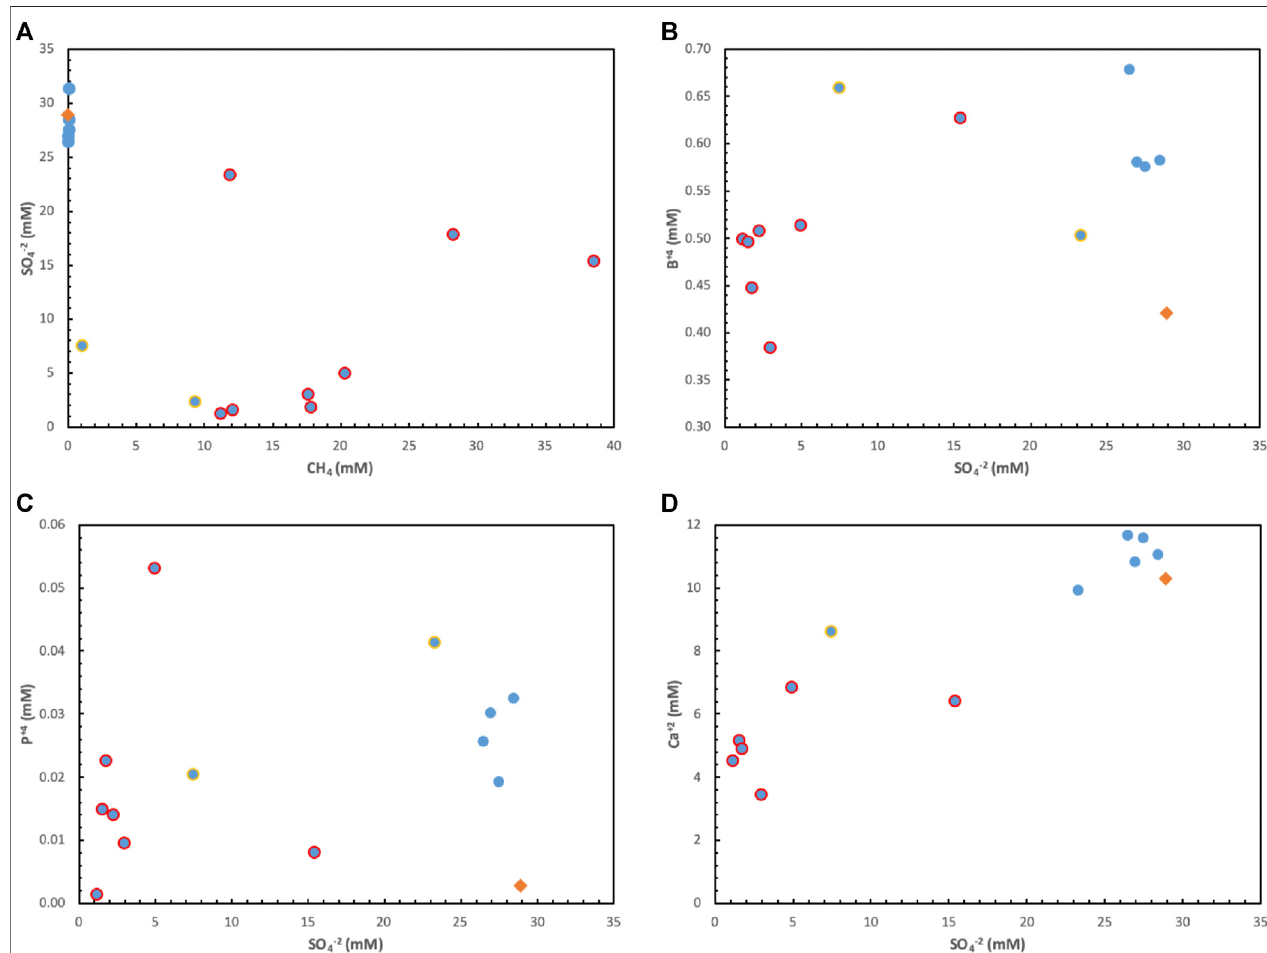
FIGURE 9 | Pore water summary graphs for methane alteration processes. In each plot orange diamond is seawater reference. Samples with > 10 mM methane outlined in red, and 1 – 10 mM methane outlined in orange. Methane-poor samples ( < 1 mM) have no outline. (A) Head-space methane gas concentration vs. pore water sulfate concentration.Many methane-rich samples aredepleted insulfate. (B) Sulfate vs. boronconcentration inpore waters. Methane-poor samplesenriched inB with respect to seawater, re fl ecting organic matter degradation without sulfate reduction. Most methane-rich samples have B concentrations closer to seawater. (C) Sulfate vs. phosphorous concentration in pore waters. Methane-poor samples enriched in P with respect to seawater, re fl ecting organic matter degradation without sulfatereduction.Mostmethane-rich sampleshave Pconcentrationscloser toseawater, but 2methane-rich sampleshave highPconcentration. (D) Sulfatevs. calcium concentration in pore waters. Methane-poor samples have sulfate and Ca concentrations near seawater but methane-rich samples have depleted sulfate and Ca from carbonate precipitation.